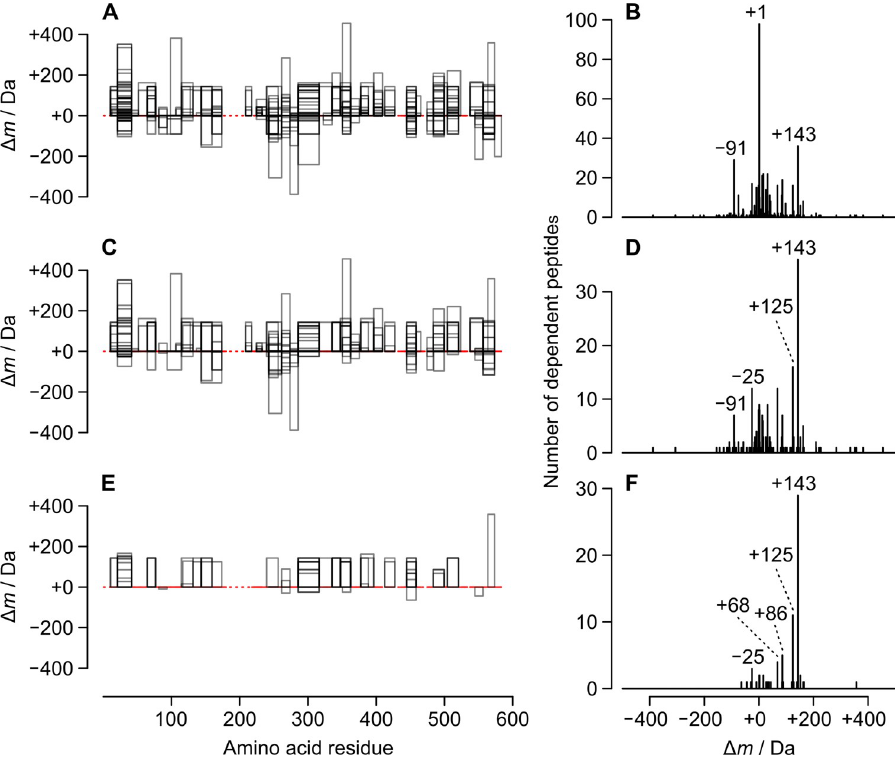
Fig 1. Localisation plots and mass-shift ( Δ m ) frequency histograms for dependent peptides (DPs) of N - ethylmaleimide-treated bovine serum albumin. In the localisation plots (left-hand panels), the protein sequence is represented as a dashed line that becomes solid in regions for which peptides were observed. X-axis values refer to positions in the protein sequence (position 1 = N-terminal amino acid residue). Each DP is represented as a rectangle whose height is proportional to Δ m , and whose grey border is partially transparent. The Δ m values are summarised in frequency histograms (right-hand panels). The DPs were unenriched (A, B), enriched using S2 Script (C, D) or enriched using S3 Script (E,